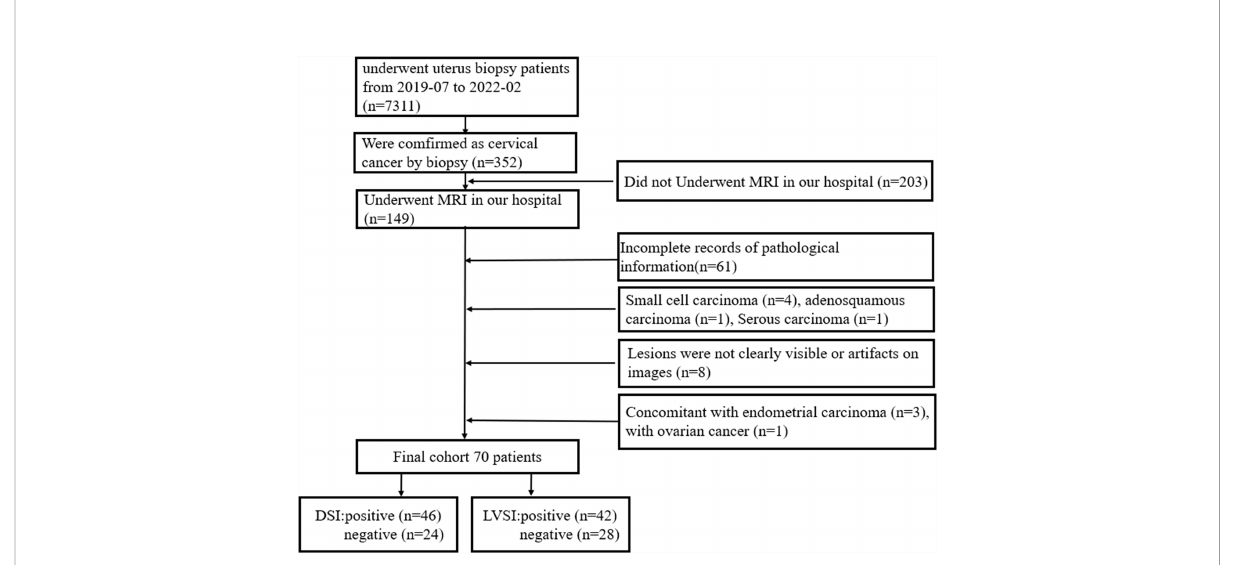
FIGURE 1 The study fl ow diagram, including the patient selection